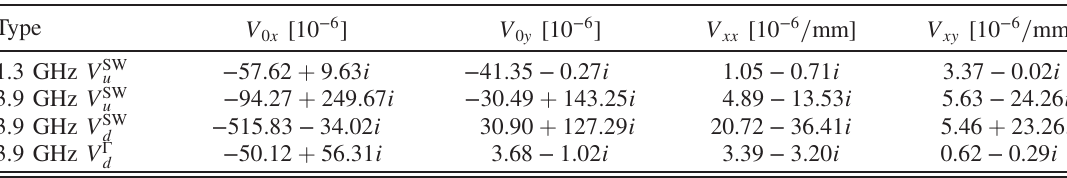
TABLE I. Coupler kick coefficients of the upstream coupler for the standing wave, V SW u (1.3 GHz cavity) and corresponding upstream and downstream V SW u , V SW d and the downstream reflection dependent part, V Γ d , for the 3.9 GHz cavity [cf. Eq.